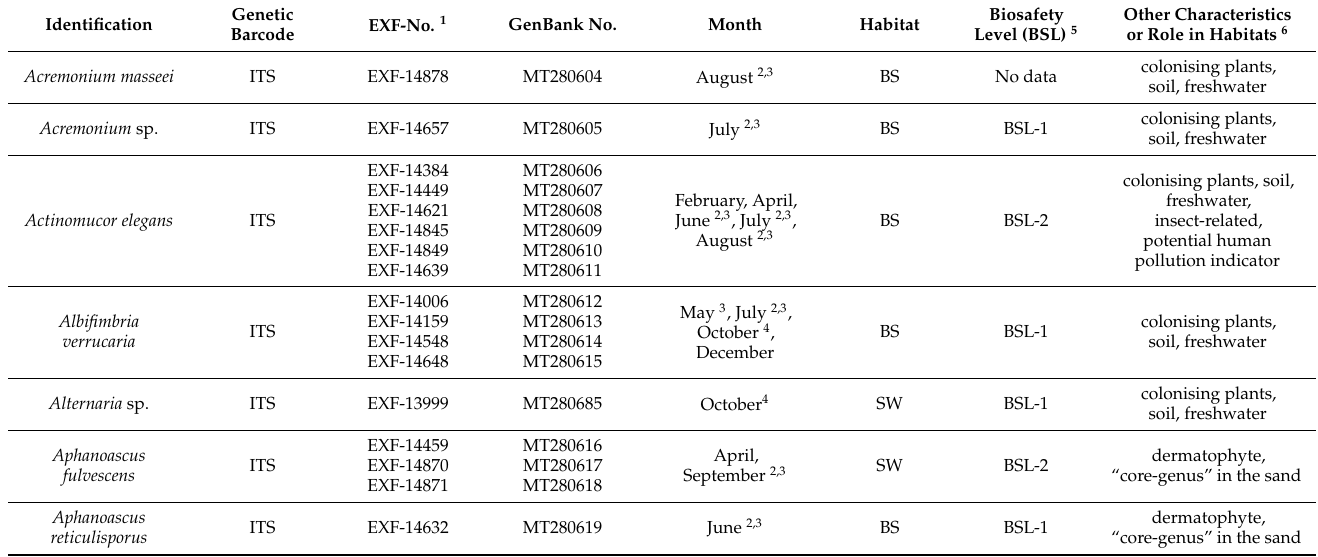
Table 1. Fungal species isolated from beach sand and seawater in Portorož, Slovenia during the